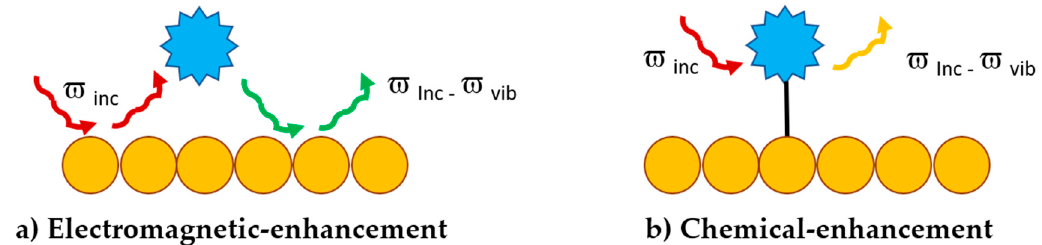
Figure 10. Two mechanisms at the base of the Raman signal enhancement: ( a ) electromagnetic and ( b ) chemical.